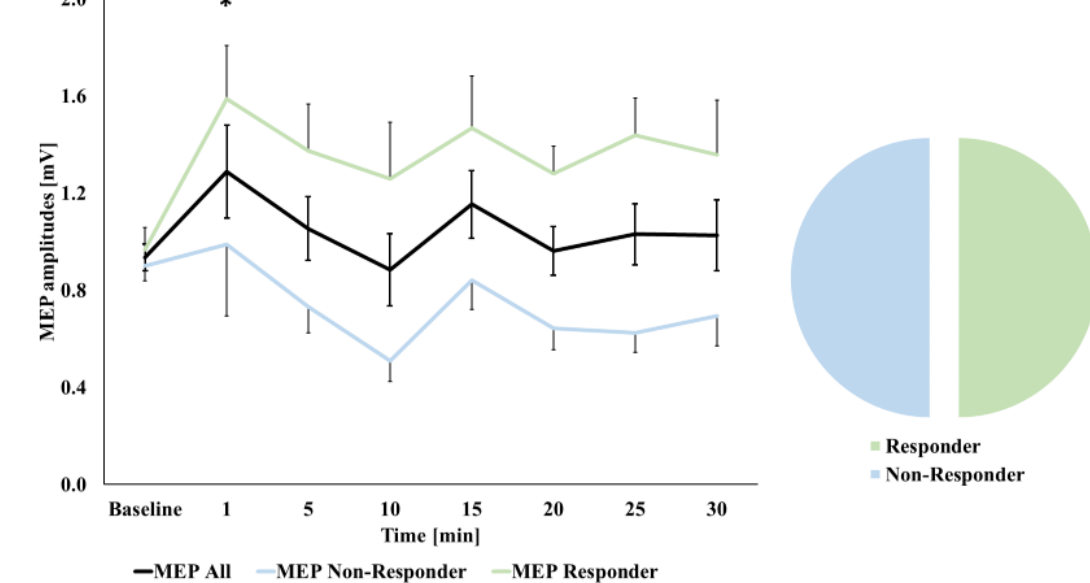
Figure 2. Motor-evoked potential (MEP) curves at baseline and following cTBS 300 stimulation. Time bins are reported in minutes. Black curve: MEP curve of all subjects; green curve: MEP curve of participants showing expected after effects (MEP magnitude increase; shown for a >100% threshold here); blue curve: MEP curve of participants showing unexpected after-effects. * indicates the observed significant effect (LSD test without Bonferroni correction) on the level of all participants. Error bars refer to standard error (SEM).